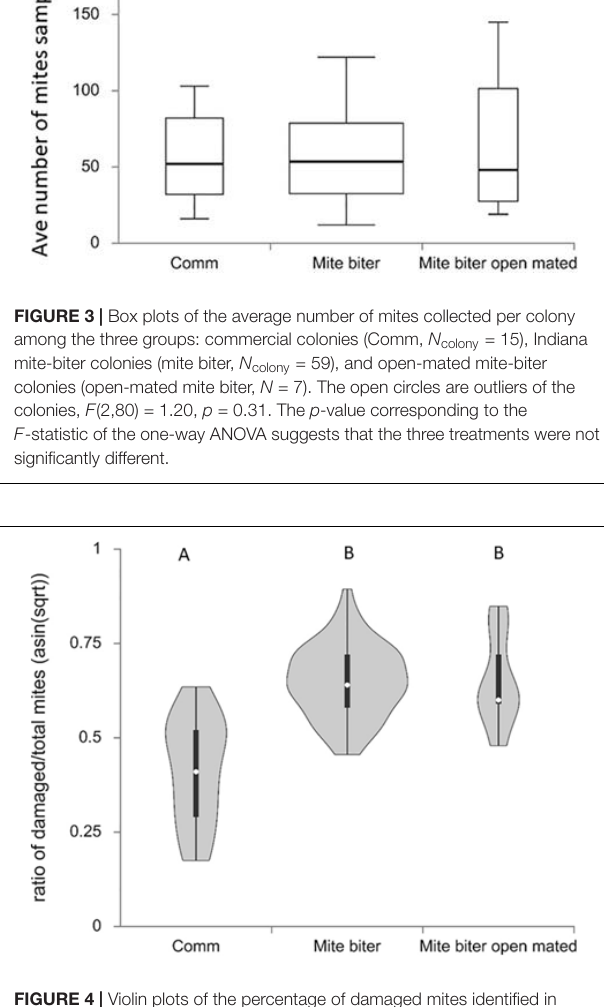
Frontiers in Ecology and Evolution |